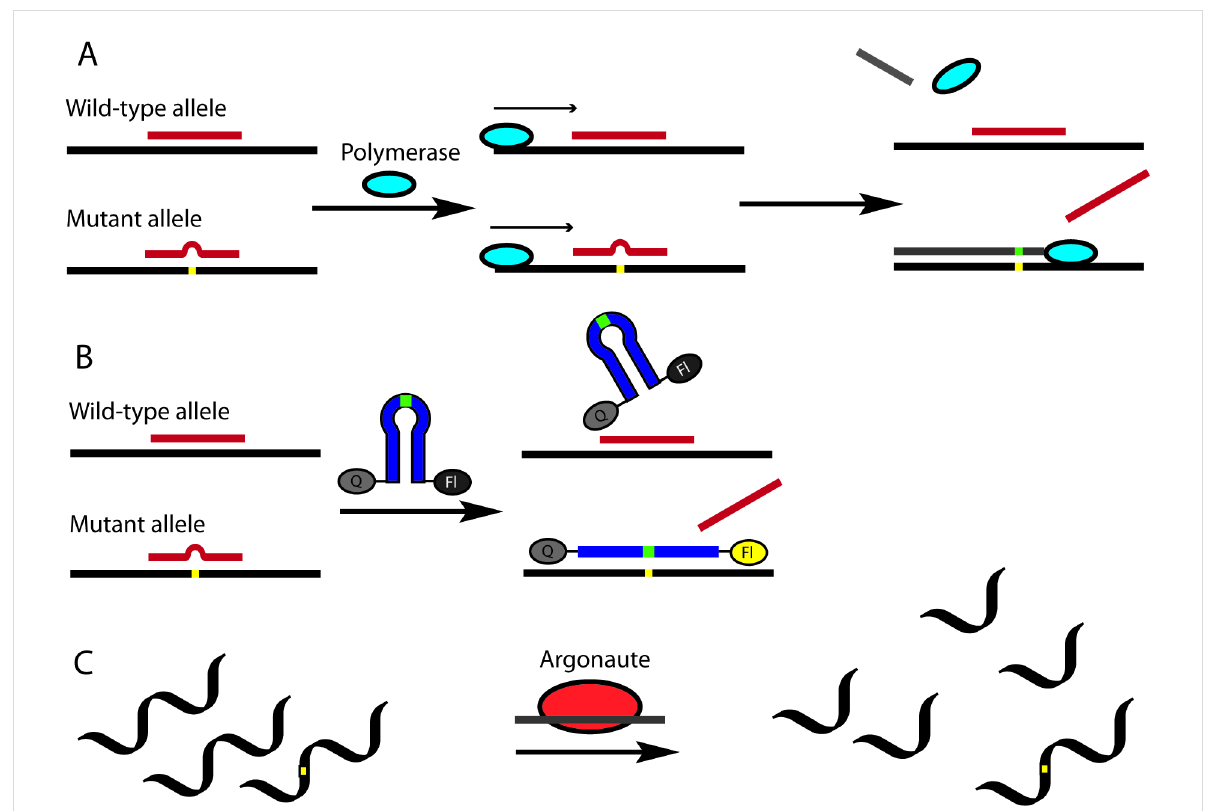
Figure 21: PNA clamp (red) binding to target DNA containing a mixture of sequences (A) PNA binds with higher affinity to the perfectly matched wild- type sequence while binding to the mutant containing as few as one mismatch is weaker. Once elongation begins, the perfectly matched complex stalls the polymerase inhibiting elongation while the mismatched complex dissociates allowing for elongation to continue; (B) LNA probes (blue) can also out compete PNA/DNA complexes mismatched allowing for sequence selective detection of mutant alleles; (C) NAVIGATER uses DNA-guided Argonaute to selective degrade wild-type oligos to enrich the mutant population increasing the sensitivity of PCR